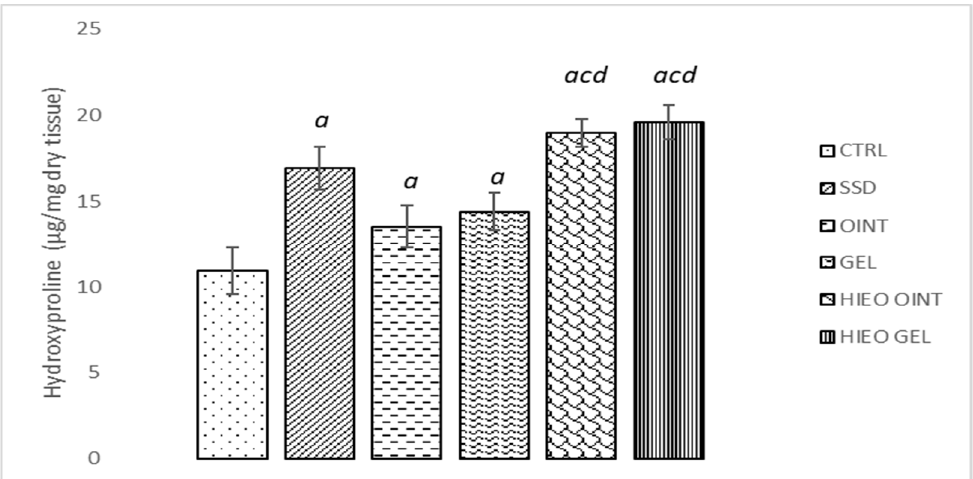
Figure 3. Effects of applied formulations on the hydroxyproline content. Values are expressed as mean ± standard deviation. Values p < 0.05 were considered to be statistically significant. a Statistical significance in relation to CTRL group; c Statistical significance in relation to OINT group; d Statistical significance in relation to GEL group.